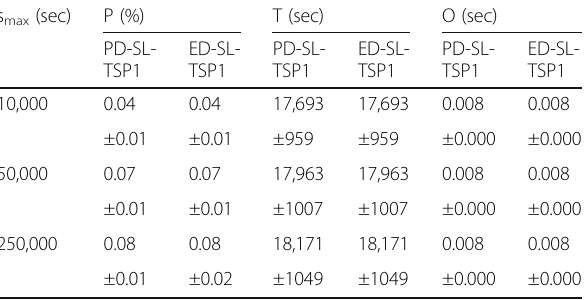
Table 5 Genome workload: effect of s max on P , T , and O